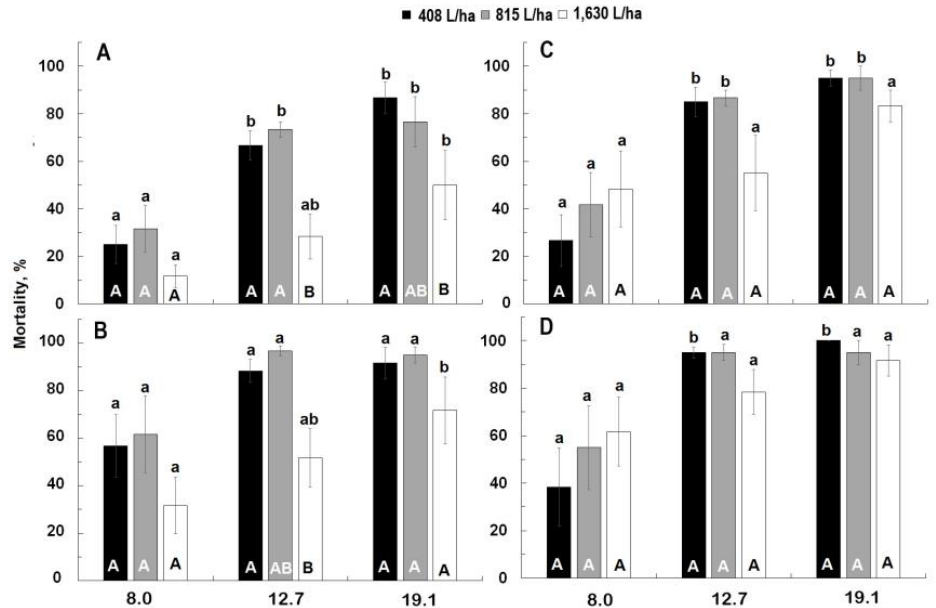
Figure 2. Effect of three Civitas rates (( A , B ): 8.0, 12.7, 19.1 L/ha) and three Silwet rates (( C , D ): 0.56, 0.80, 1.27 L/ha) applied at different carrier volumes (408, 815, 1630 L/ha) on mortality of adult Listronotus maculicollis evaluated at 3 h ( A , C ) and 24 h ( B , D ). Means marked with the same lower-case letter do not differ statistically within the application volume. Means marked with the same capital letter do not differ significantly within rate.